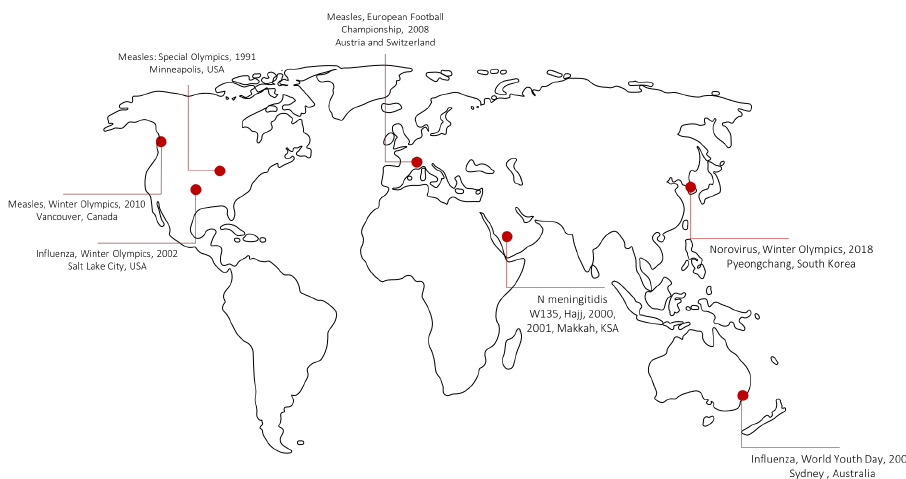
Figure 1. Some of the major reported disease outbreaks in different global gatherings.